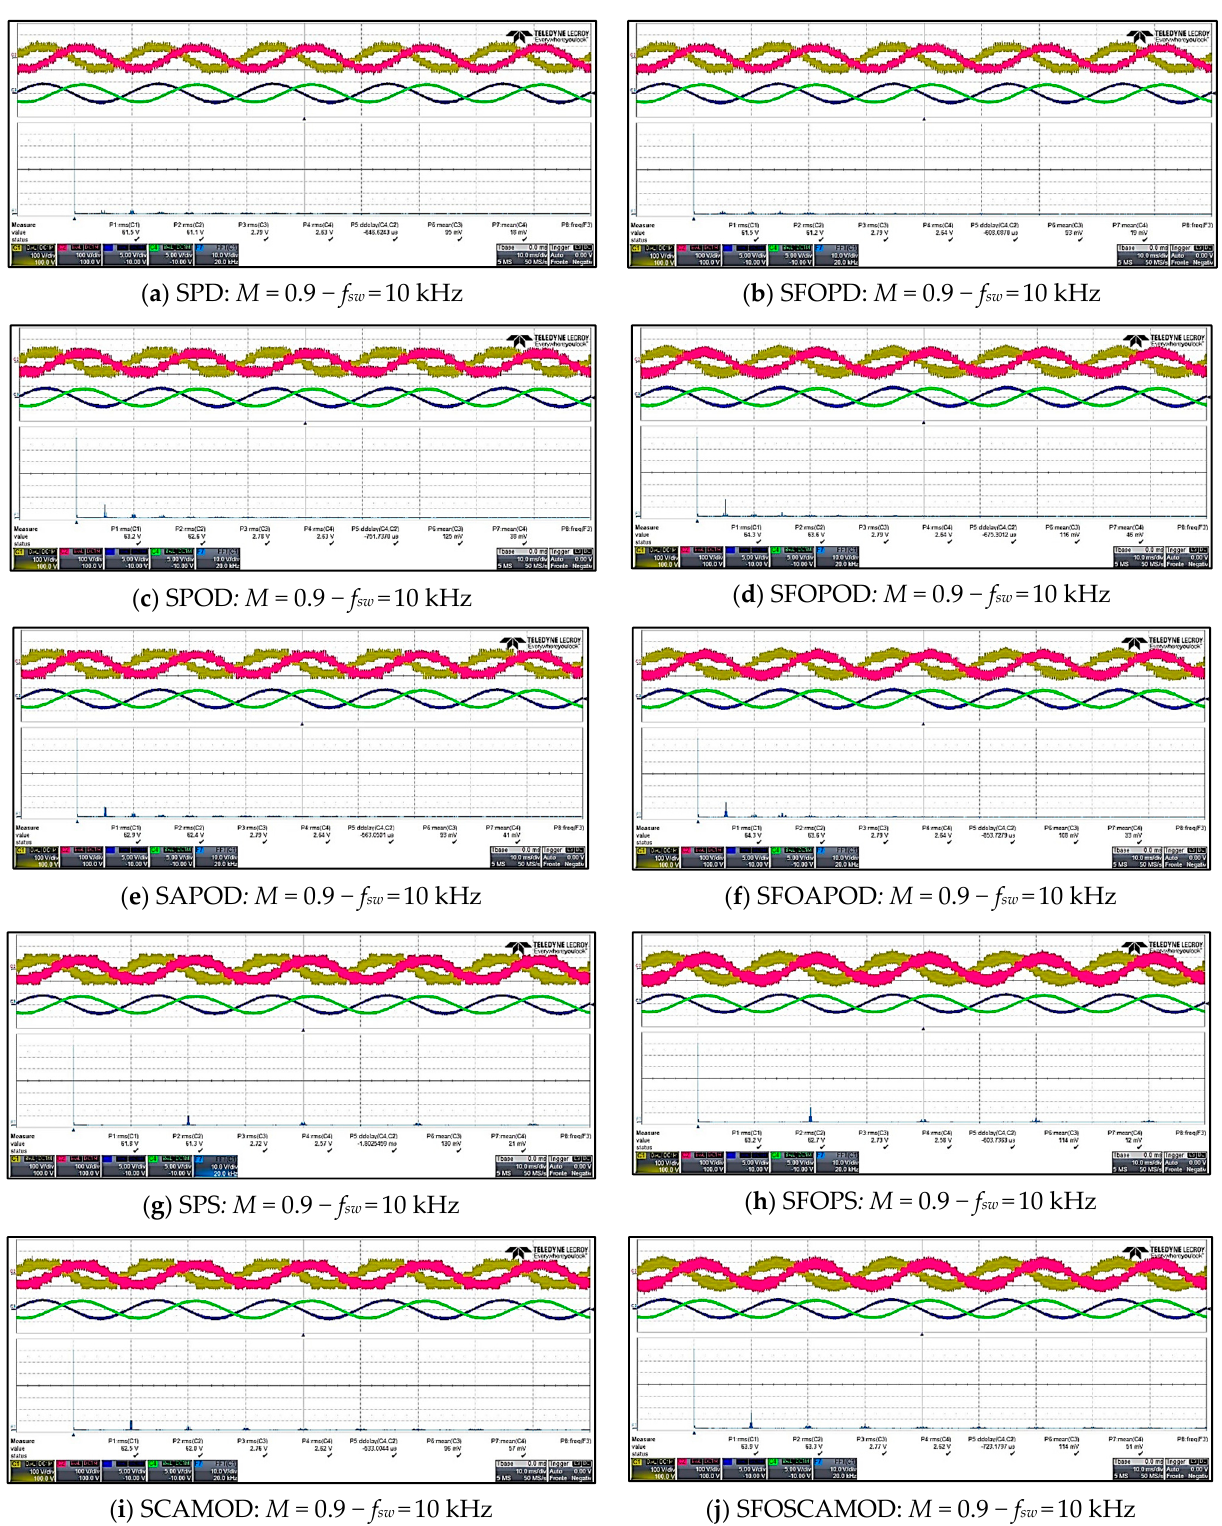
Figure 12. Real ‐ time acquisition at switching frequency equal to 10 kHz of the phase voltages, line currents, and corresponding harmonic spectra in the frequency domain of the modulation schemes: ( a ) SPD; ( b ) SFOPD; ( c ) SPOD; ( d ) SFO POD; ( e ) SAPOD; ( f ) SFOAPOD; ( g ) SPS; ( h ) SFOPS; ( i ) SCAMOD; ( j ) SFO SCAMOD.